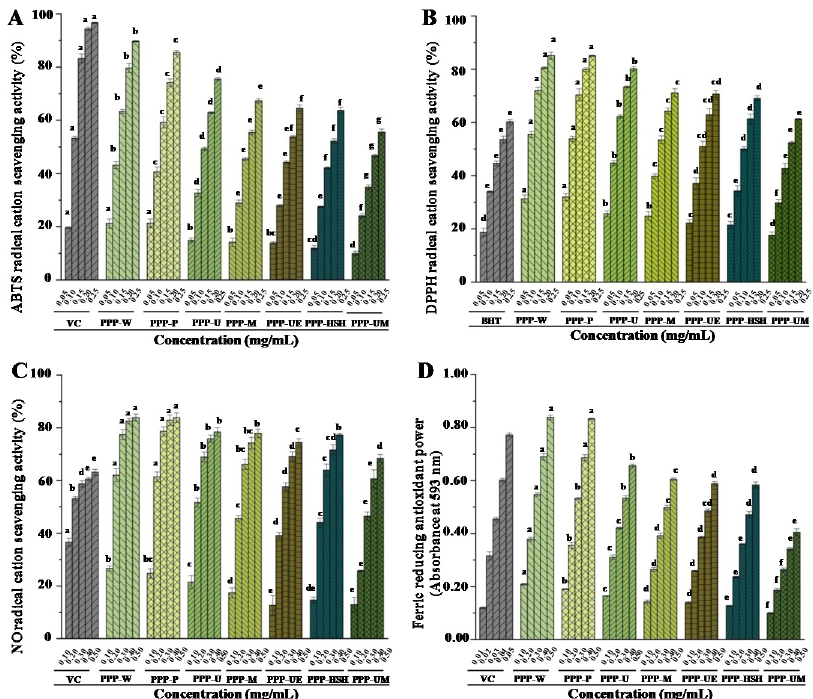
Figure 3. ABTS (A), DPPH (B), and nitric oxide (C) radical scavenging activities, as well as ferric reducing antioxidant powers (D) of PPPs. The codes of samples were the same as in Table 1; ABTS, 2,2 ′ -azino-bis(3-ethylbenzthiazoline-6-sulphonic acid); DPPH, 2,2-diphenyl-1-(2,4,6-trinitrophenyl) hydrazyl; Vc, vitamin C; BHT, butylated hydroxytoluene; The error bars are standard deviations; Significant (p < 0.05) differences are shown by data bearing different letters (a–h); Statistical significances were performed by ANOVA and Duncan’s test.